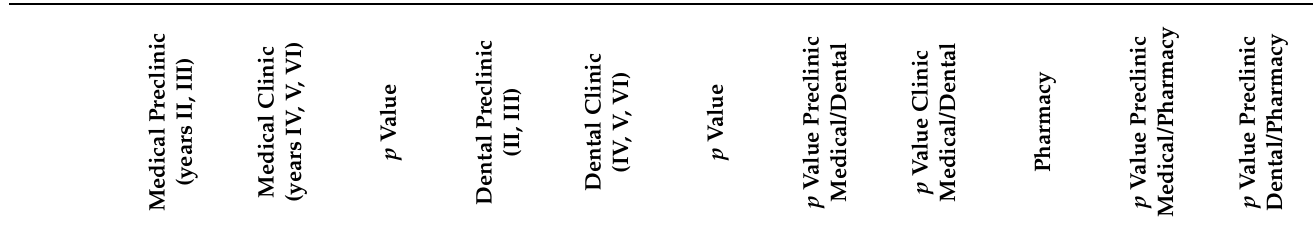
Table 1. The questionnaire—part